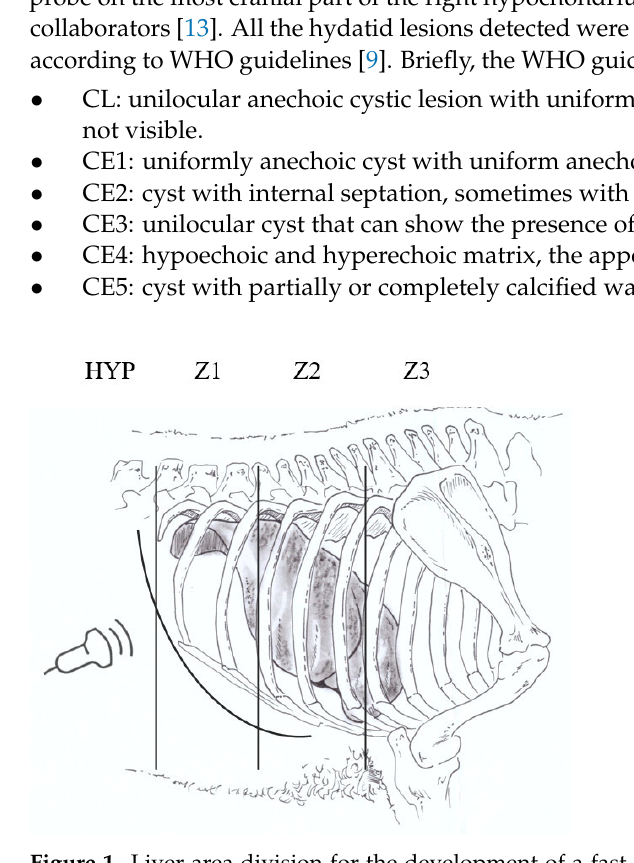
Figure 1. Liver area division for the development of a fast-scanning procedure. HYP: liver scan through hypochondrium; Z1: liver scan from hypochondrium to 11th intercostal space; Z2: liver scan from 10th to 8th intercostal space; Z3: liver scan from 7th to 5th intercostal space. Finally, recorded data were also considered for contiguous scans (HYP + Z1; Z1 + Z2, Z2 +